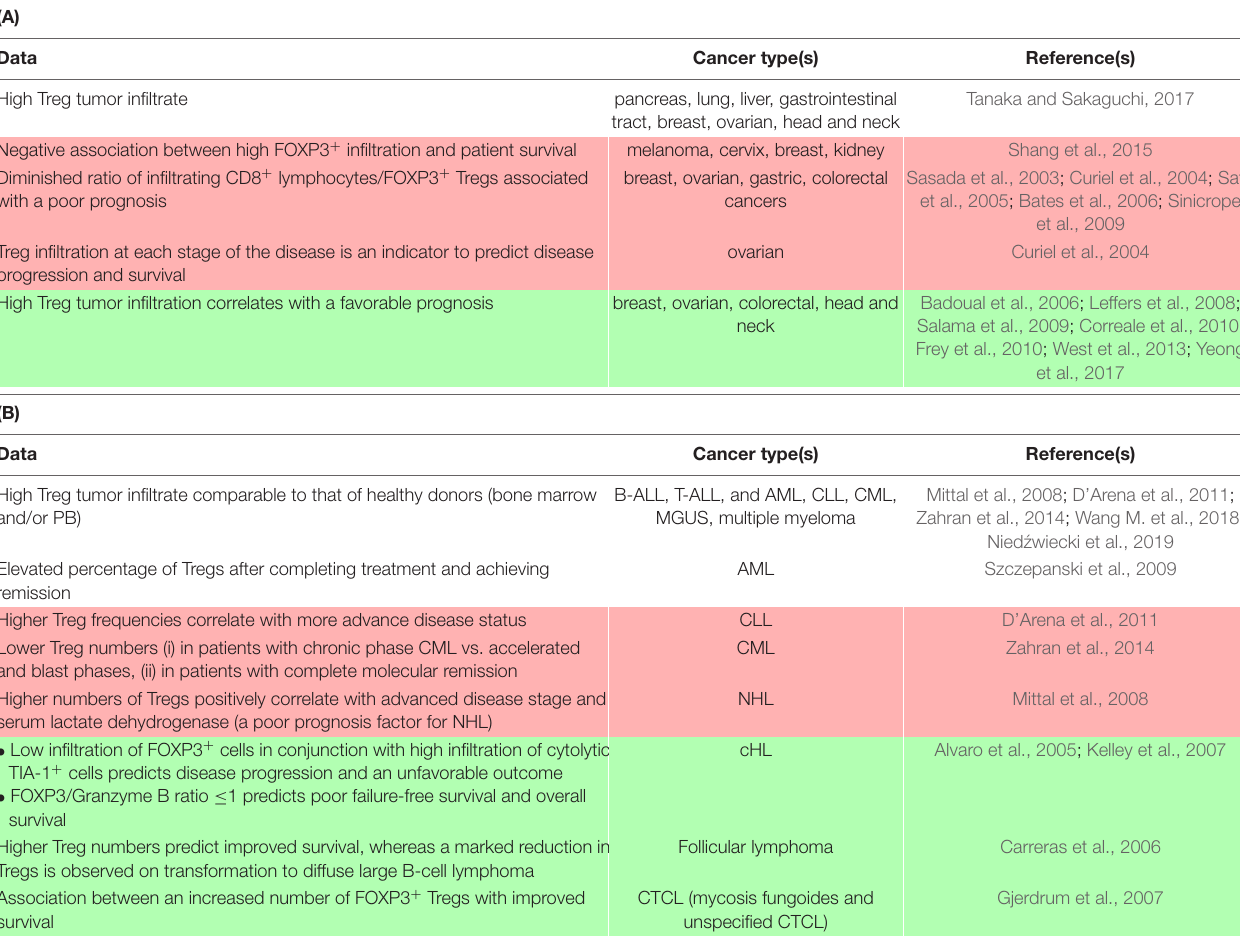
TABLE 1 | Detection and clinical association of Tregs in carcinomas (A) and hematological malignancies